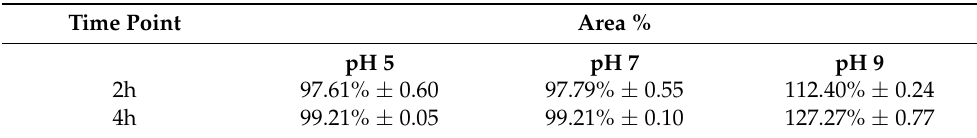
Table 2. Stability of ODAF at different pHs. Results are expressed as percentage of peak area in comparison with the standard solutions at the same concentrations.